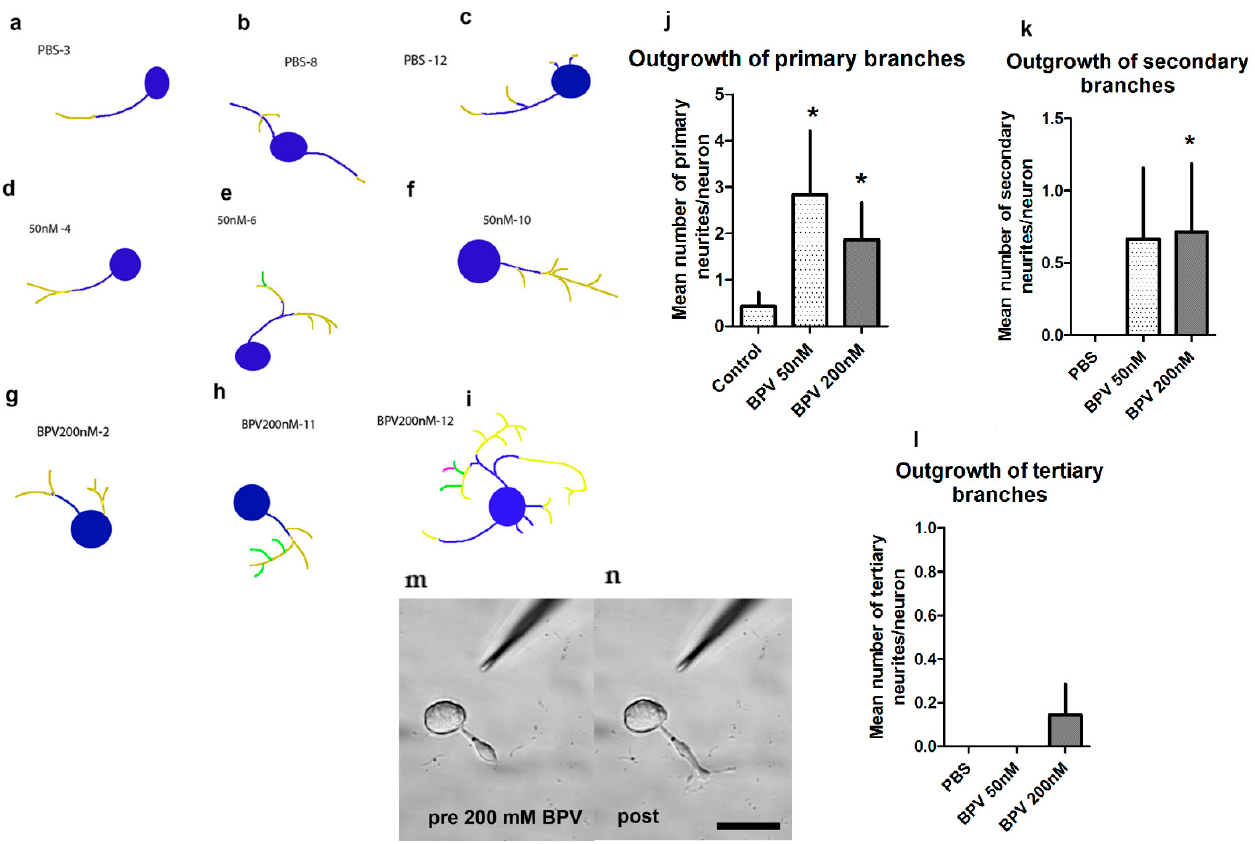
Figure 4. Using a classical growth cone turning assay, perikarya-directed PTEN inhibition induced distal neurite branching. ( a – i ) The PTEN inhibitor bp(v)pic (BPV) was directed by a picospritzer to the perikarya, instead of the growth cone, of immunoselected GFR α 1 adult sensory neurons. Different doses of BPV (( d – f ) 50 nM BPV and ( g – i ) 200 nM BPV) were compared with carrier PBS. The original configuration of the neurons is illustrated in blue. New primary branches are illustrated in yellow, new secondary branches are illustrated in green, and tertiary branches are illustrated in pink. There were significant rises in primary branches ( j ) and secondary branches ( k ), and, in one case, tertiary branches ( l ) when perikarya were exposed to higher dose BPV. An individual neuron imaged by brightfield microscopy before ( m ) and after ( n ) 60 min of growth is illustrated in response to 200 nmol/L BPV applied to its perikarya. Note the rise in branches in neurites distant from the side of application of the PTEN inhibitor. Scale bar = 50 µm.* p < 0.05 compared to control. The Figure is reproduced with permission from Guo et al. [172].